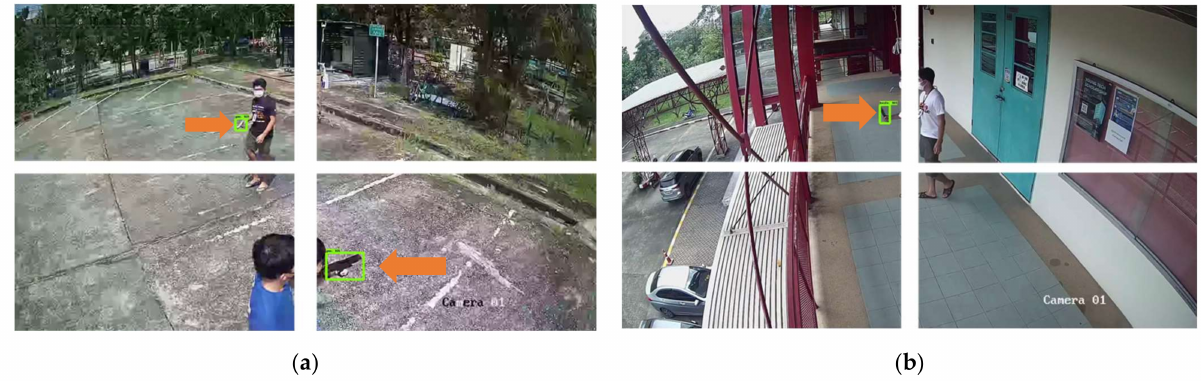
Figure 14. SSD MobileNet V2 model prediction on example images using ( a ) Tiling Test Dataset 1 and ( b ) Tiling Test Dataset 2.